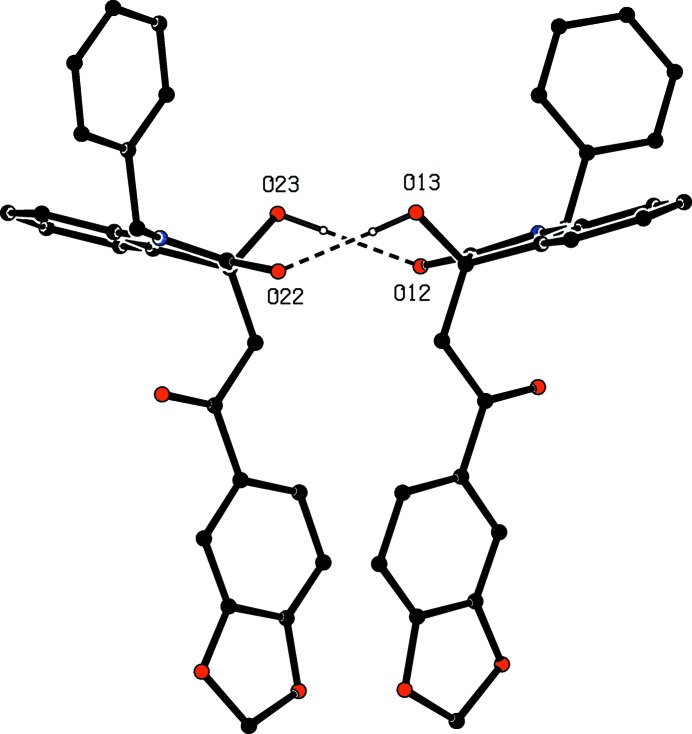
Part of the crystal structure of com­pound (If), showing the linking of the two independent mol­ecules by two independent O—H⋯O hydrogen bonds. Hydrogen bonds are drawn as dashed lines and, for the sake of clarity, H atoms not involved in the motifs shown have been omitted.